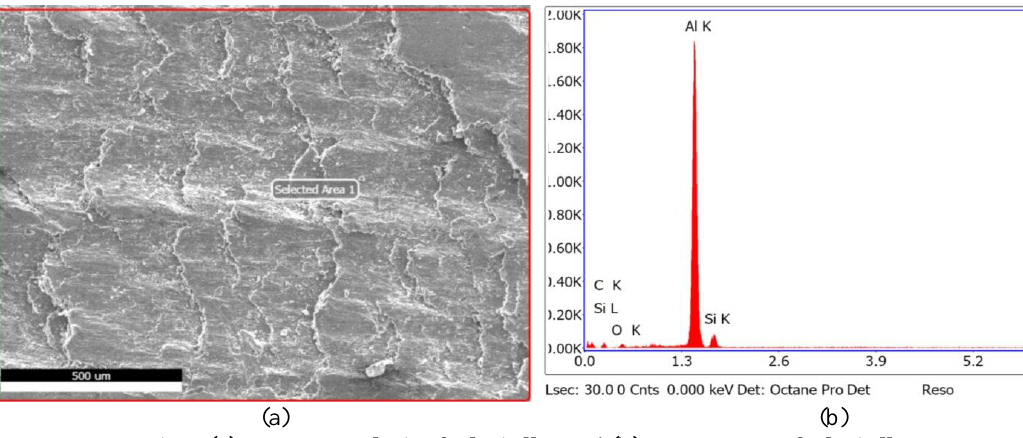
Fig. 4.(a) FE-SEM analysis of Al-Si alloy and (b) EDX spectra of Al-Si alloy